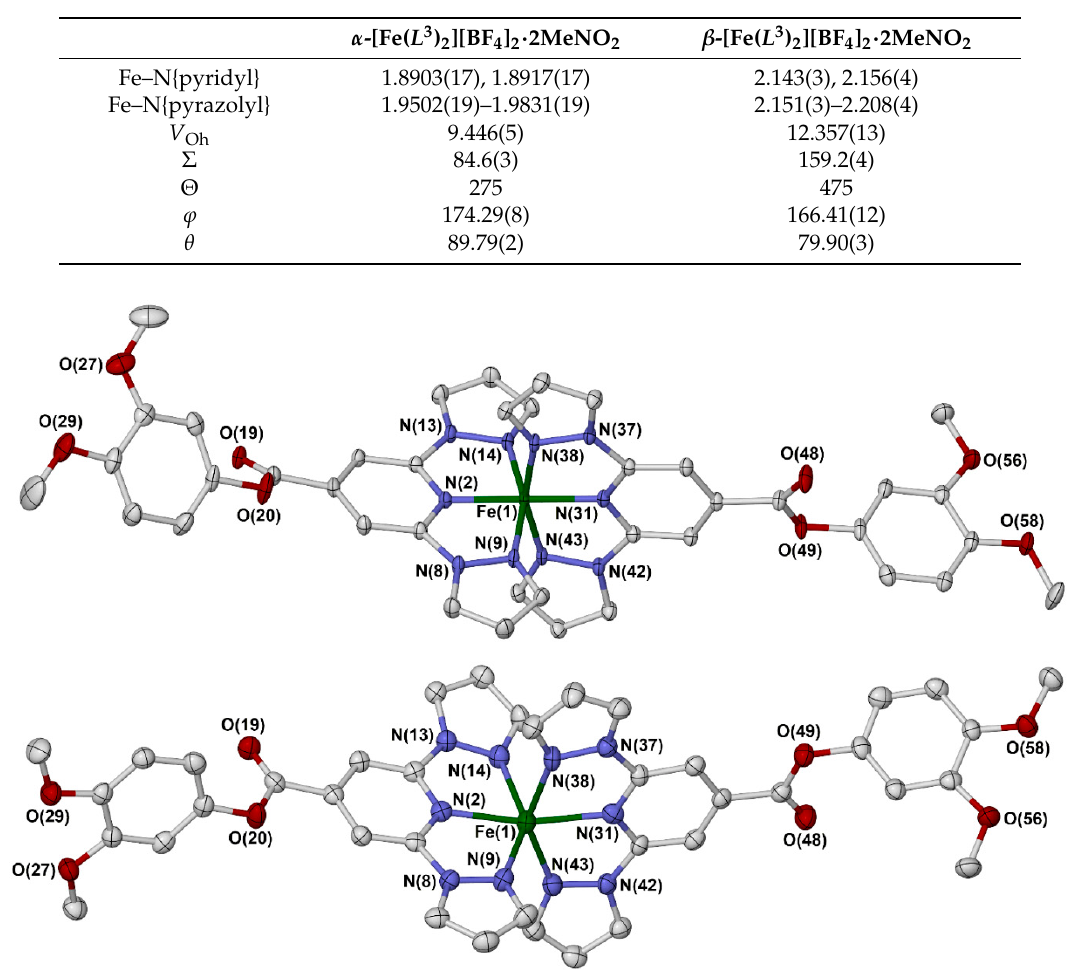
Table 1 Metric parameters for the two polymorphs of [Fe( L 3 ) 2 ][BF 4 ] 2 ·2MeNO 2 (Å, Å 3 , º). V Oh , Σ and Θ are indices characteristic for the spin state of the complex [50,54], while θ and φ are defined in the text [50]. Typical values of these parameters in [Fe(bpp) 2 ] 2+ derivatives are given in [22] and [55].